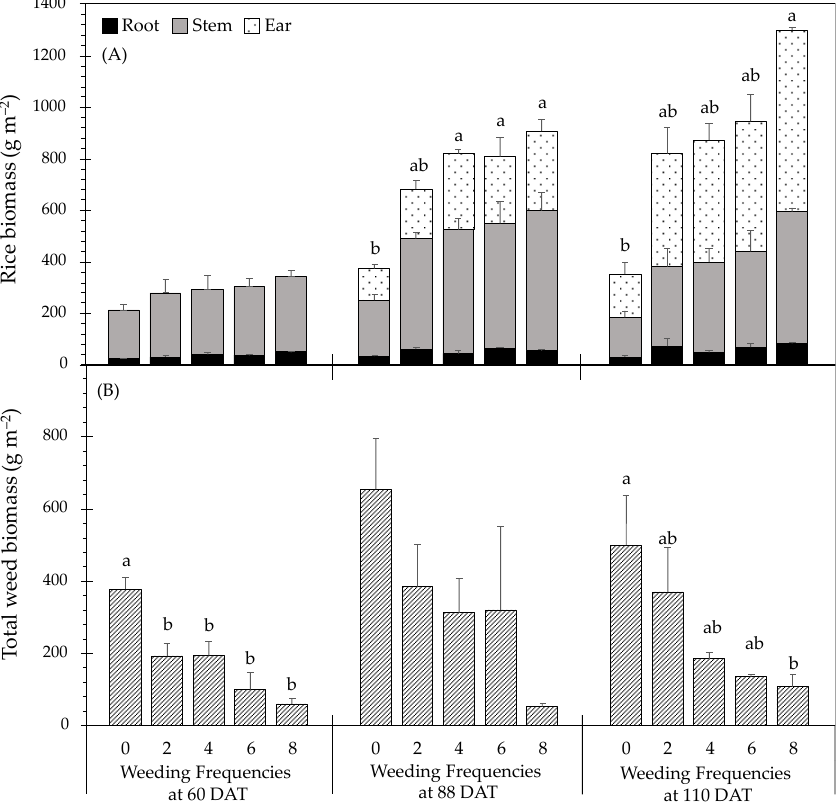
Figure 2. Effect of weeding frequencies on ( A ) rice biomass (the contribution in root, stem, and ear) and ( B ) total weed biomass at 60, 88, and 110 DAT (days after transplantation). Bars indicate stand- ard error ( n = 4). Different letters within sampling times indicate significant differences in total rice biomass or total weed biomass among treatments at p < 0.05 based on Tukey’s HSD test. The inter‑ vals of mechanical weeding until 49 DAT were 0, 2, 4, 6, and 8. The weed biomass was suppressed under the weeding treatment. The total weed bi- omass was significant at 60 and 110 DAT. However, the weeding frequencies decreased the weed biomass at 88 DAT. Comparing the other treatments to 0WF, we found that 2WF and 4WF reduced the weed biomass by 49 and 48%, respectively, while 6WF and 8WF reduced it by 74 and 84%, respectively, at 60 DAT. E. crus-galli , M. vaginalis , and S. juncoides responded to the weeding frequencies, with the most prominent decrease in biomass at 8WF. The E. crus-galli biomass significantly decreased at 60 DAT, whereas the M. vaginalis did not show significant changes. While the S. juncoides significantly decreased at 110 DAT (Table S2), the total weed biomass at 8WF (106.77 g m –2 ) was the only significant treatment when they were all compared with 0WF (501.09 g m –2 ). Weeds at 110 DAT and 2WF, 4WF, 6WF, and 8WF displayed reduc- tions of 26, 63, 73, and 79%, respectively, when compared to 0WF. 3.2. Weed Diversity and Percentage In this study, three major weeds grow in the field, i.e., annual weed E. crus-galli , S. juncoides , and perennial weed M. vaginalis (Burm. f.) and are described in percentages (Fig- ure 3). The weeds responded to weeding frequencies differently. The weed biomass per- centage shows that E. crus-galli was the most dominant weed in almost all treatments, but the percentage tended to decrease with an increase in the weeding frequency. In 0WF to